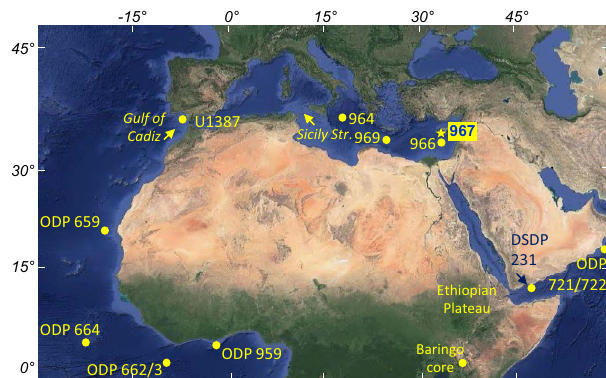
Fig. 1 Locations of sites discussed in this study. Eastern Mediterranean sites are from Ocean Drilling Programme (ODP) Leg 160 ref. 29 Base